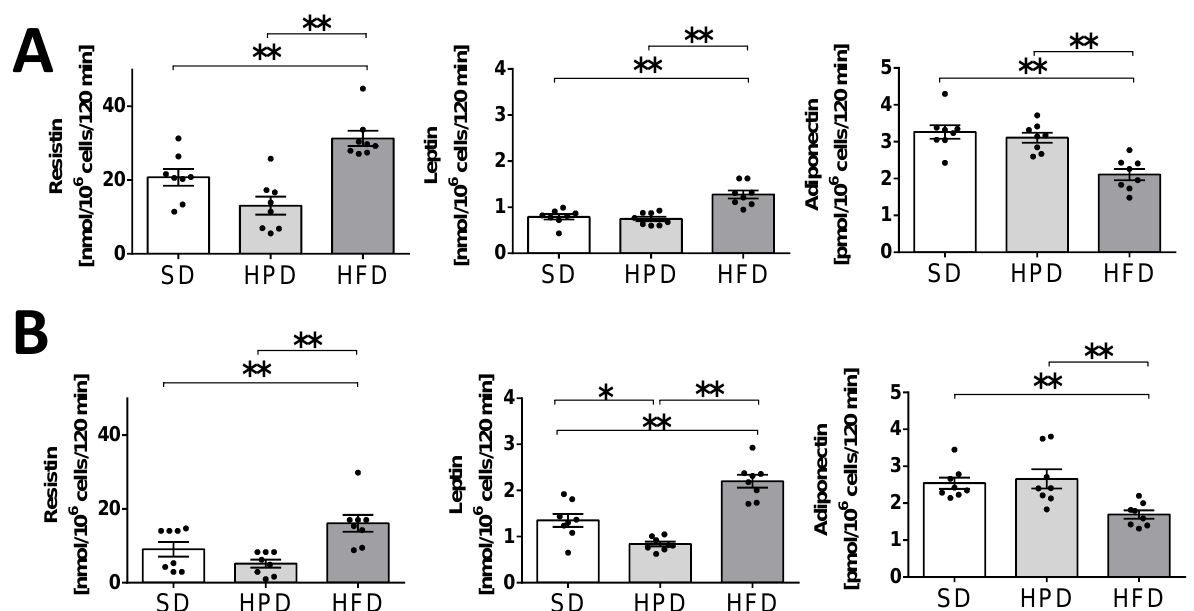
Figure 4. The effects of high-protein and high-fat diets on resistin, adiponectin, and leptin secretion from isolated rat adipocytes after 60 ( A ) and 120 days ( B ). Cells were incubated for 2 h in Krebs–Ringer buffer; hormones’ concentrations in the medium were measured using Elisa kits. Results are means ± SEM for n = 8; significant differences between means for control and experimental groups are marked for p < 0.05 (*) and p < 0.01 (**).